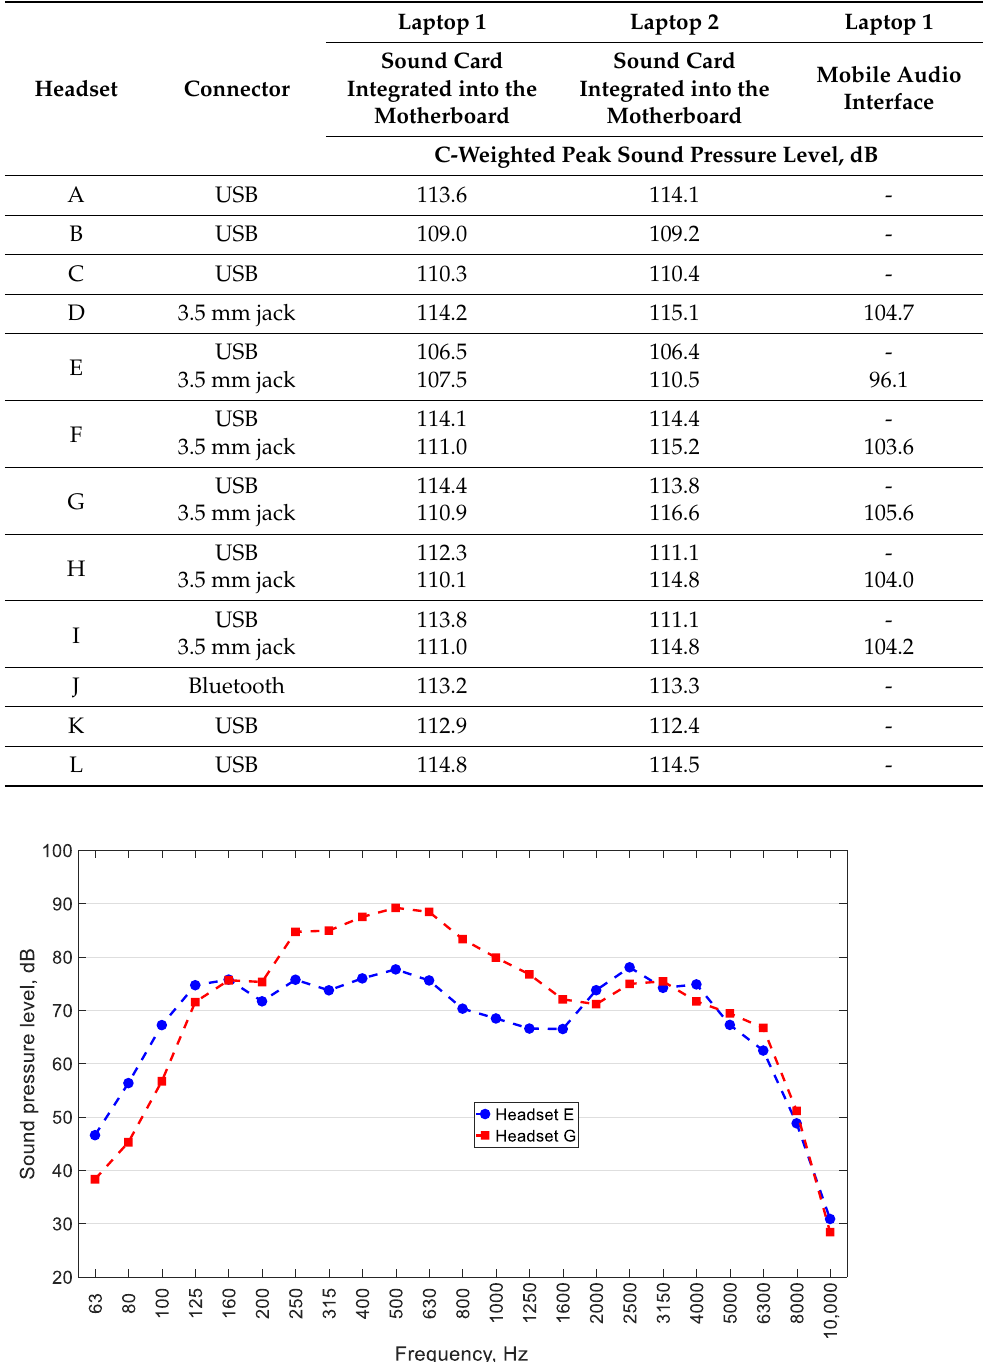
Figure 2. Sound pressure level in 1/3-octave bands of the test signal reproduced by Headsets E and G connected to Laptop 2.